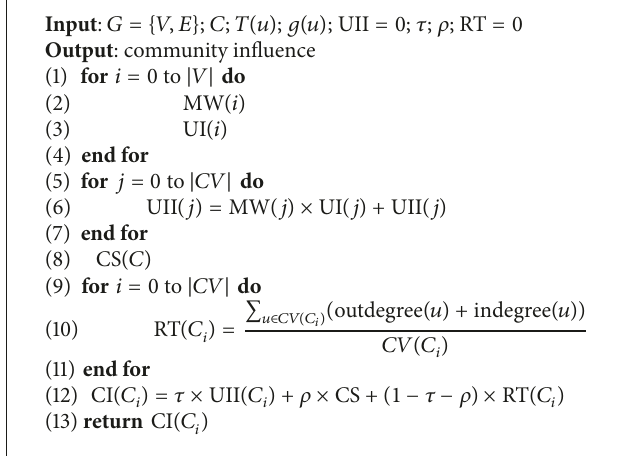
Algorithm 2: Community-level influence analysis algorithm (CIAA).